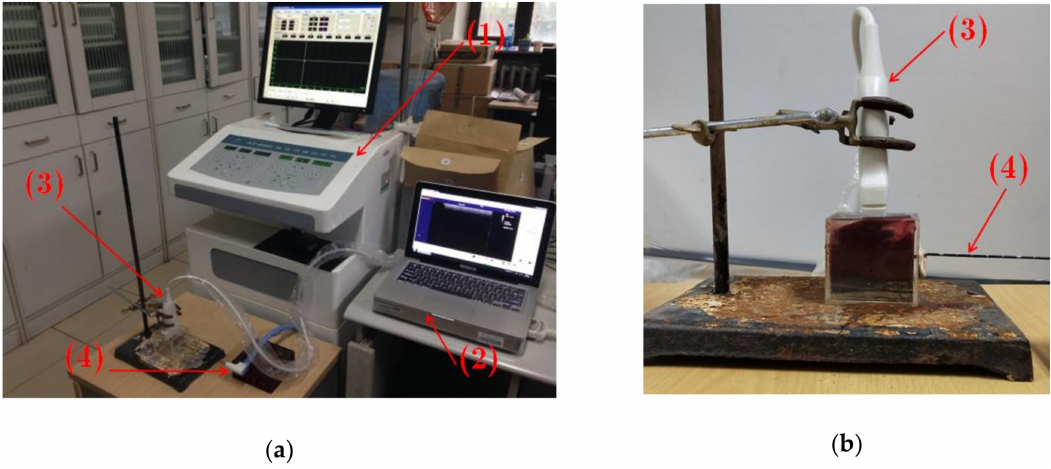
Figure 1. Experimental